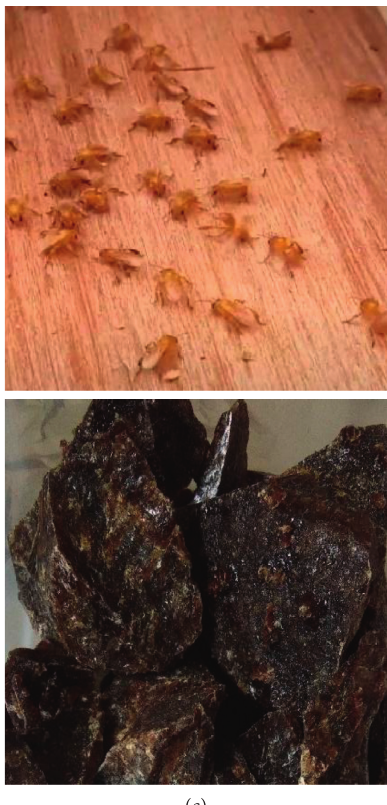
Figure 1: Images of stingless bees. (a) Tetrigona apicalis , (b) Tetrigona binghami , and (c) Homotrigona fimbriata captured along with their respective collected